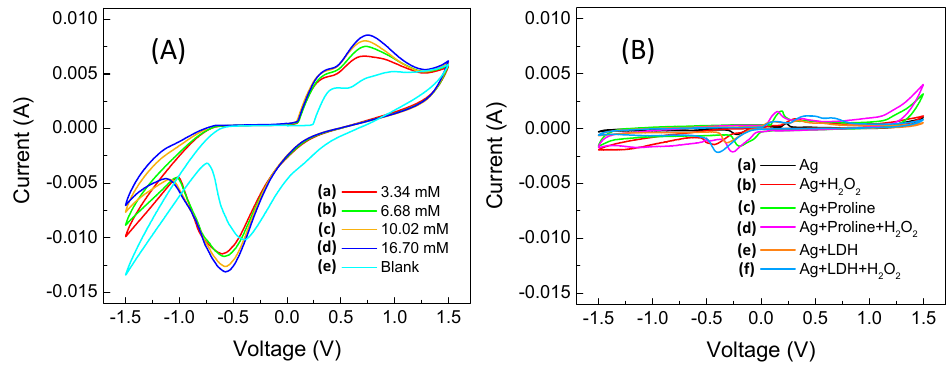
Figure 2. Cyclic voltammograms from − 1.5 V to +1.5 V with a scan rate 40 mV s − 1 ( A ) obtained using the sensor (GC-Ag paste )-catalytic proline-assisted LDH (with 20 mmol L − 1 proline in solution), with H 2 O 2 in phosphate buffer with final concentration of (a) 3.34, (b) 6.68, (c) 10.02, (d) 16.70 mmol L − 1 , and (e) without H 2 O 2 in buffer solution. ( B ) “CV Blanks” obtained using (a) GC-Ag paste , (b) GC- Ag paste in 3.34 mmol L − 1 of H 2 O 2 , (c) GC-Ag paste and proline (20 mmol L − 1 ), (d) GC-Ag paste and proline (20 mmol L − 1 ) in 3.34 mmol L − 1 of H 2 O 2 , (e) GC-Ag paste -LDH, and (f) GC-Ag paste -LDH in 3.34 mmol L − 1 of H 2 O 2 .